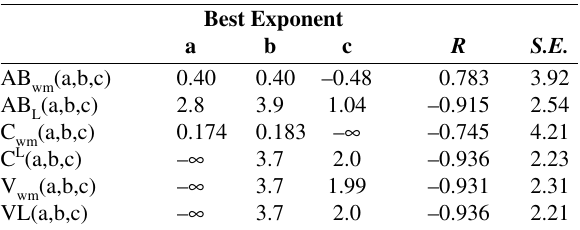
Table 1. Correlations of selected indices derived from the whole ) Universal matrix U (a,b,c) as well as from its left half ( ( wm the boiling point (BP) of all (18) octanes.